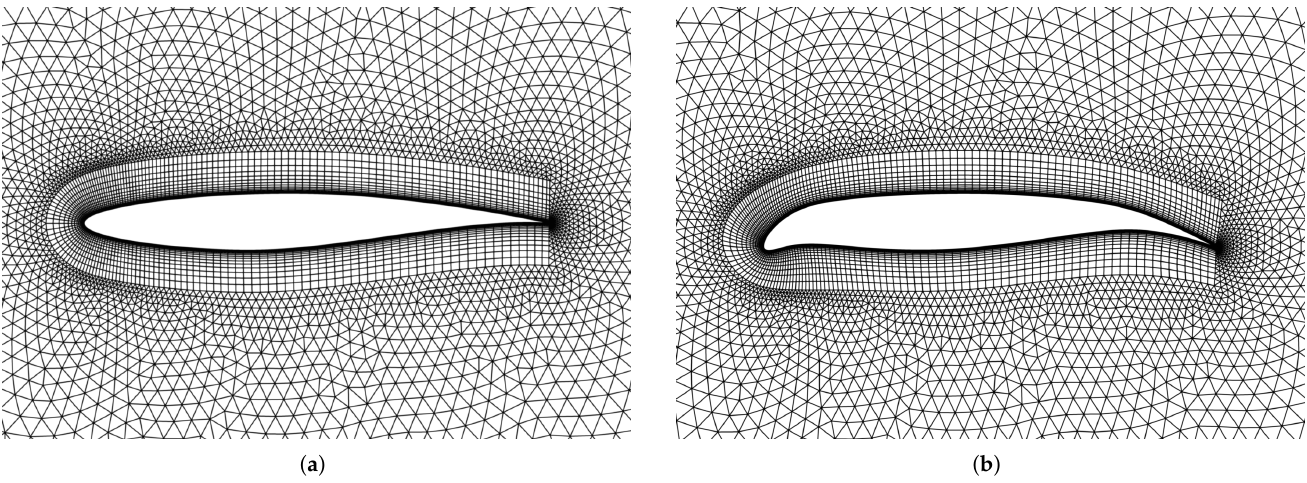
Figure 5. Mesh deformations of airfoil with morphing leading and trailing edges. ( a ) Undeformed RAE 2822 mesh. ( b ) Morphing RAE 2822